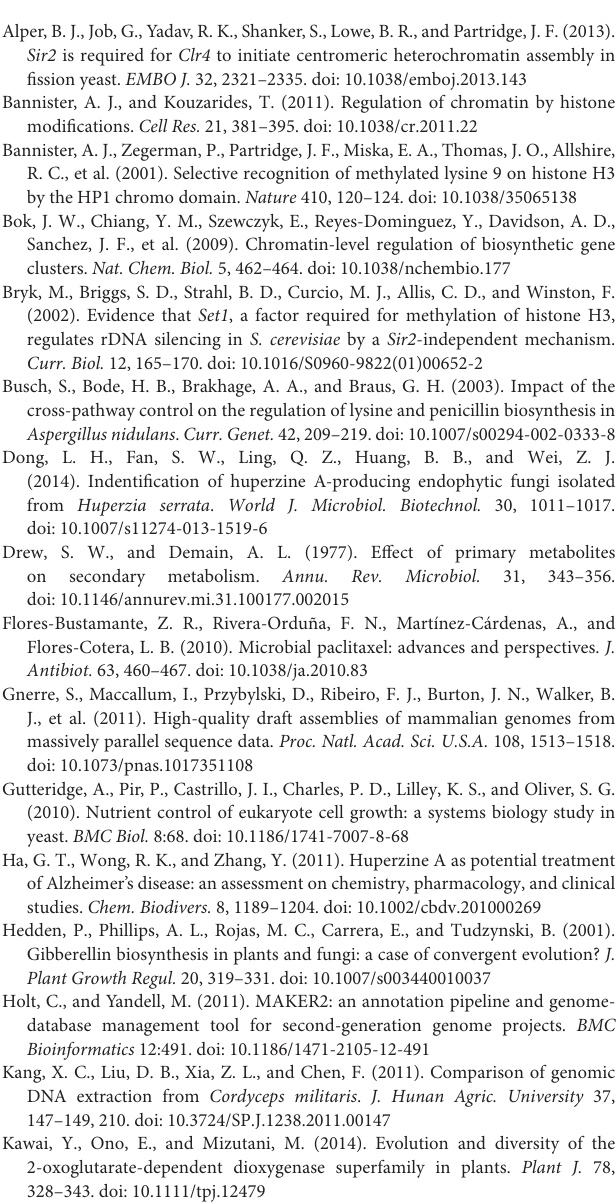
Table S8 | Expression of the LDC, CAO, BBE and PKS genes in C. gloeosporioides Cg01 and P. polonicum hy4. Table S9 | Annotation of P450s in P. polonicum hy4 and C. gloeosporioides Cg01. Table S10 | Gene expression of 2OGD in P. polonicum hy4 and C. gloeosporioides Cg01. Table S11 | Orthologues between P. polonicum hy4 and C. gloeosporioides Cg01. Table S12 | Gene expression of histone modification genes in P. polonicum hy4 and C. gloeosporioides